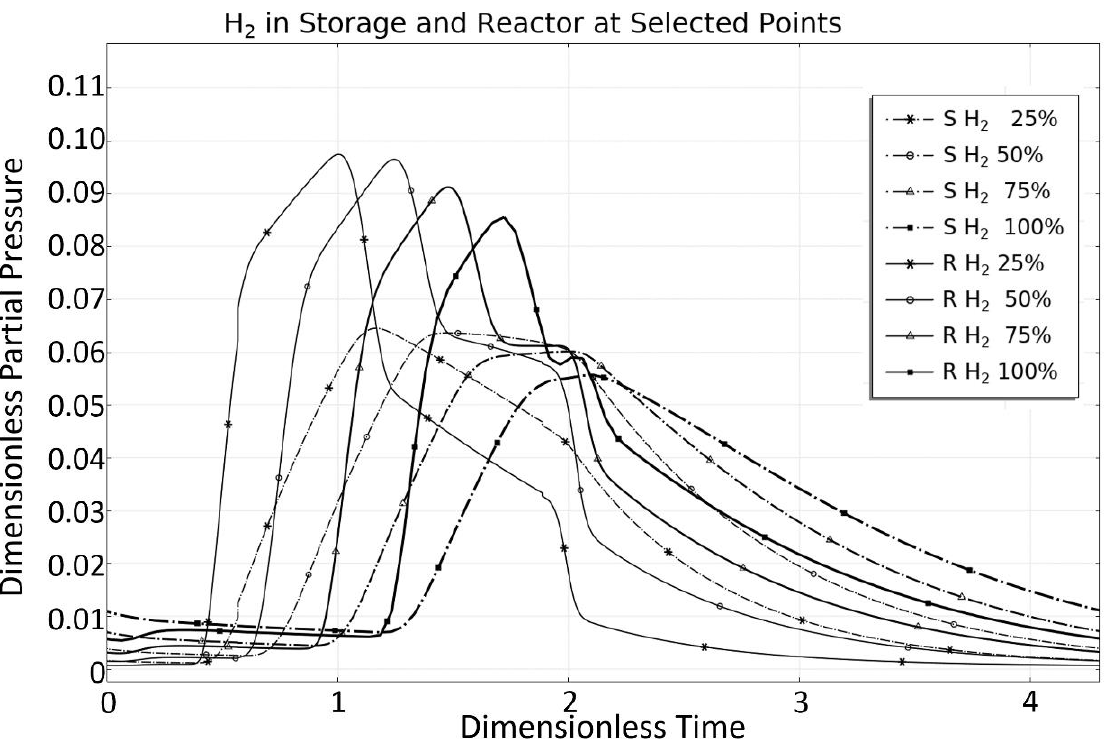
Figure 5. Dimensionless time evolution of H 2 dimensionless partial pressure in void and storage domains at four reactor lengths for the last cycle of Da = 2, Θ = 10.